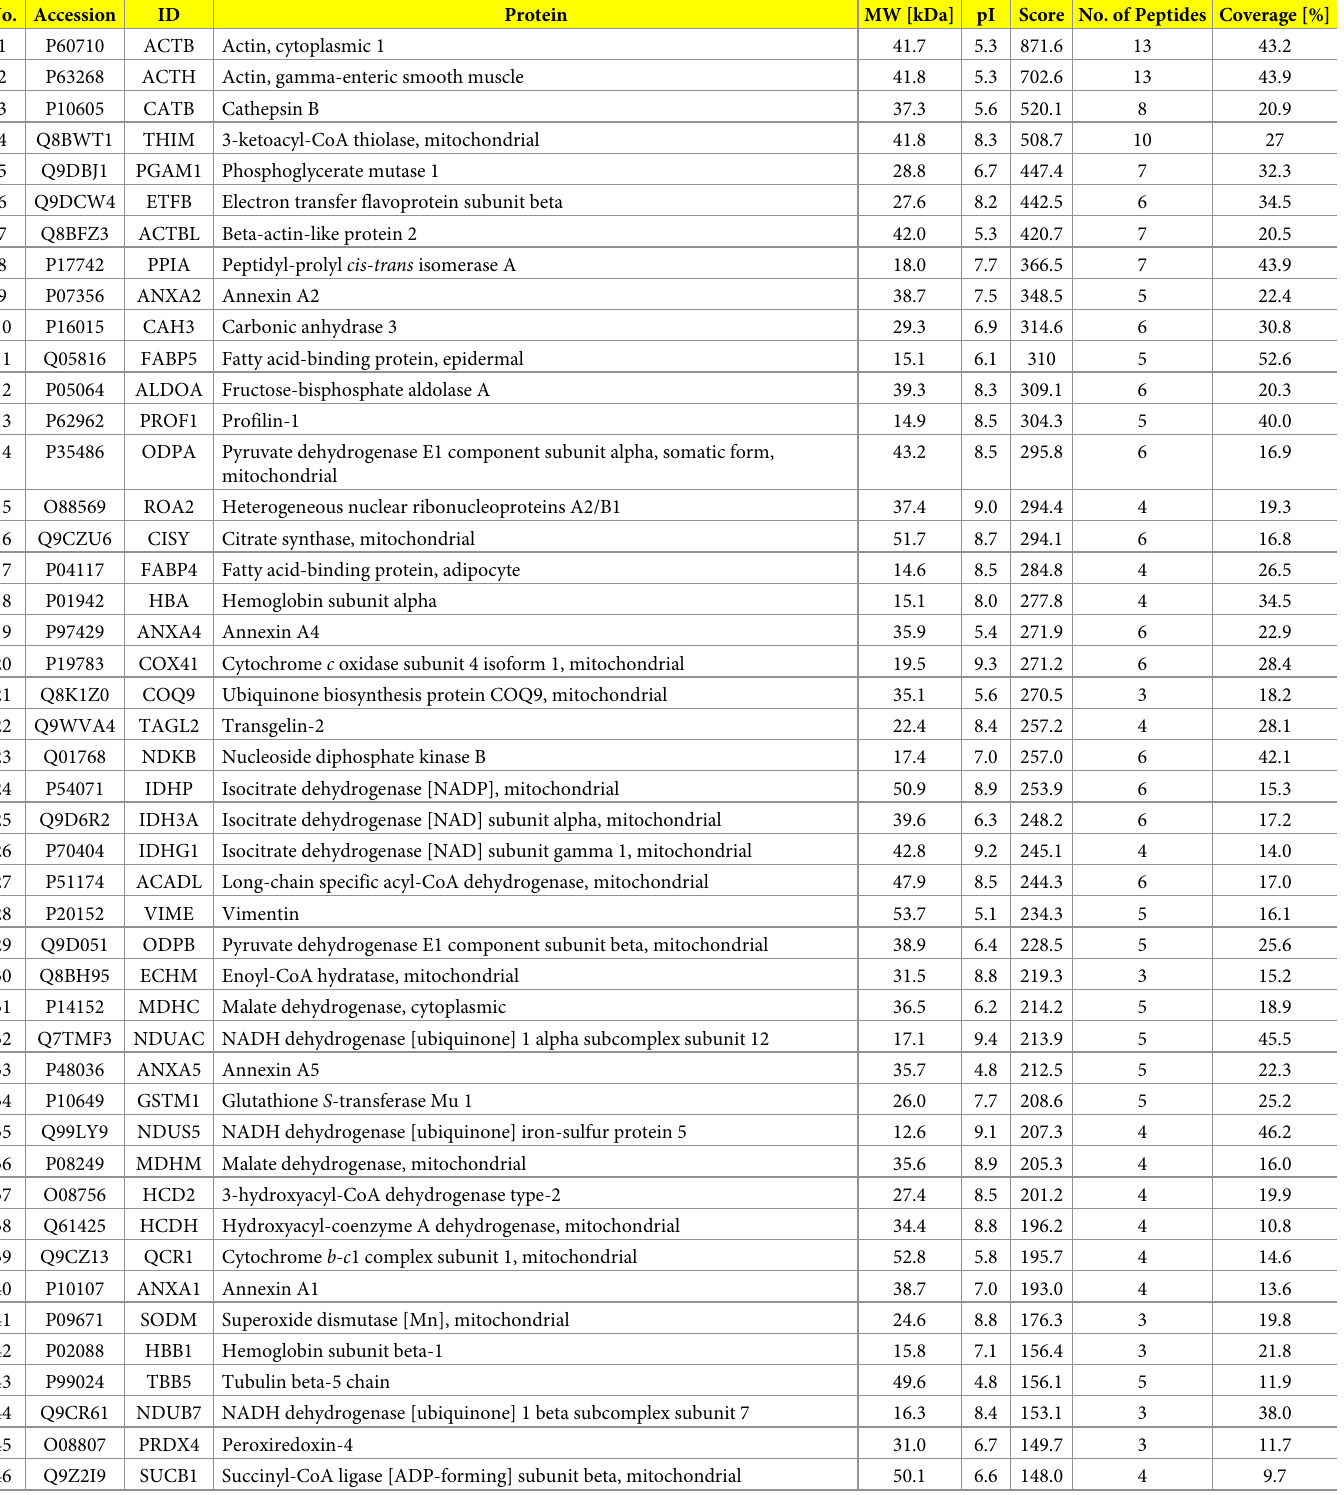
Table 1. Identified S -sulfhydrated proteins from aorta of ApoE KO mice treated with H 2